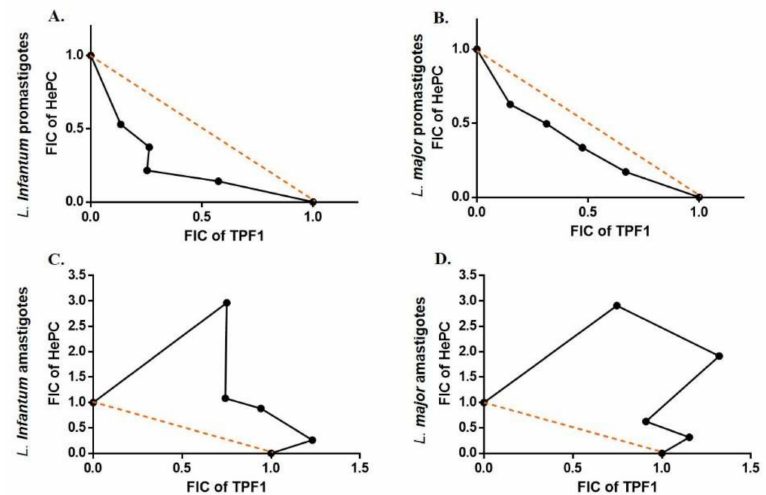
Figure 8. Representative normalized isobolograms of the interaction of TPF1 and HePC. Drug interaction was analyzed against L. infantum ( A , C ) and L. major ( B , D ) promastigotes and intracellular amastigotes. The numbers on the axes represent normalized FICs of TPF1 ( x -axis) and HePC ( y -axis). Data points (dots) located above, on, or below the line indicate antagonism, additivity, or synergy, respectively. The constructed isobolograms are the result of three independent experiments run in triplicate.